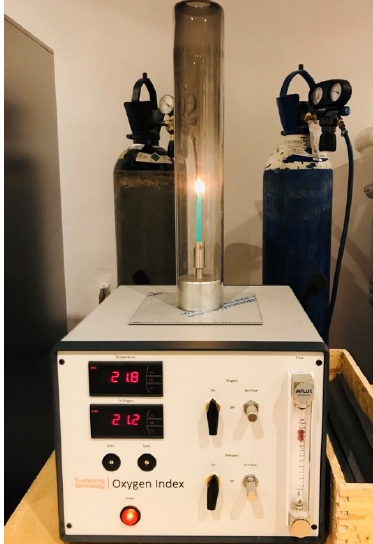
Figure 1. Fire-Testing Technology apparatus.